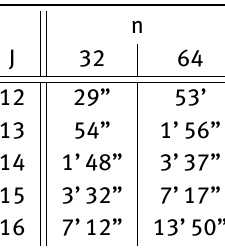
Table 5: The time to compute the regression does not depend on the Portfolio target P * , and in particular not on J * . This table reports the times spent to compute the regression for different J and n . We remark the fact that the regression time is a set-up which can be estimated once a month, and therefore since the meaningful time for the HR method is the one reported in the third column of table 4, for high Portfolio dimensions, the time saved is